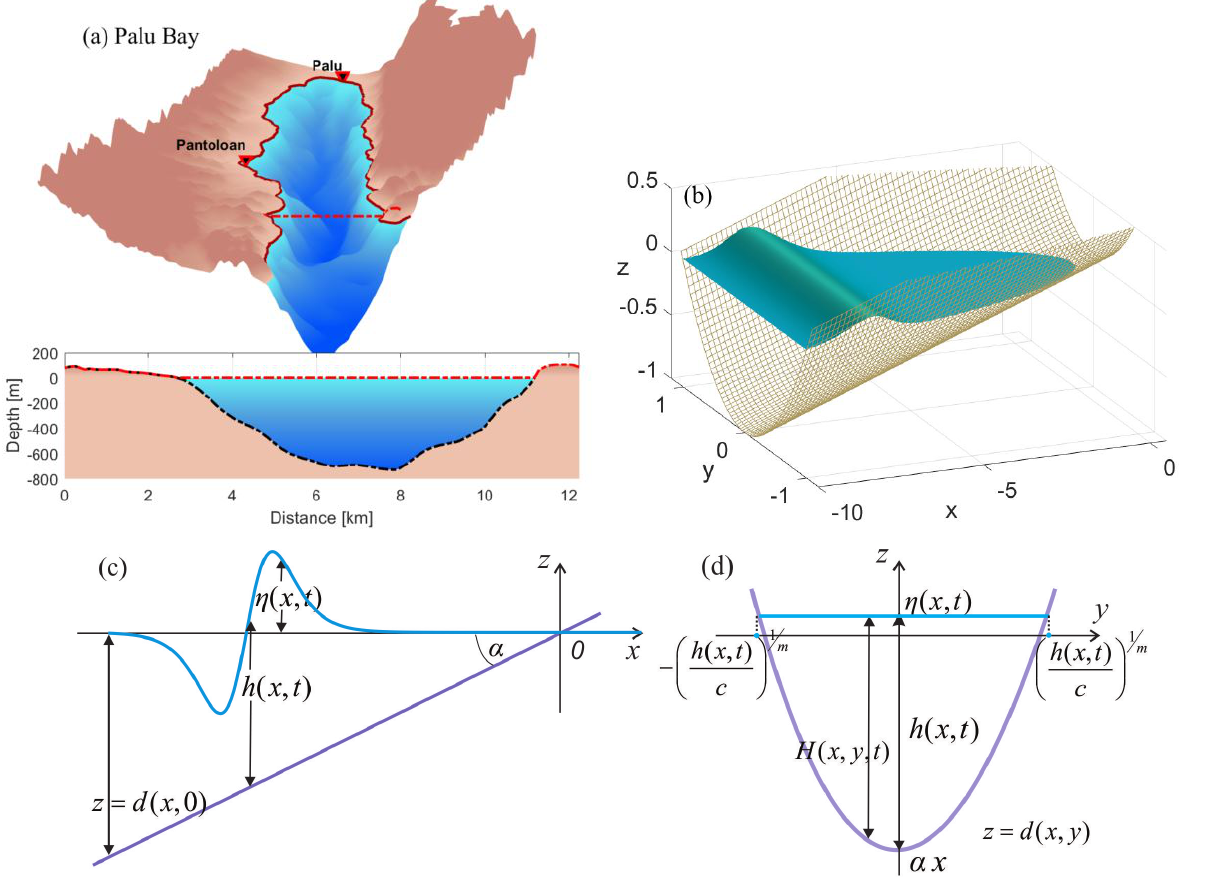
Figure 1. ( a ) The bathymetry of Palu Bay with a U-shaped cross-section (source: Badan Informasi Geospatial (BIG)); ( b ) three-dimensional sketch of the channel-bays B m ; ( c ) the longitudinal section d ( x ,0 ) = α x , for x < 0; and ( d ) the cross-sections d ( x , y ) in the form of c | y | m , for fixed m